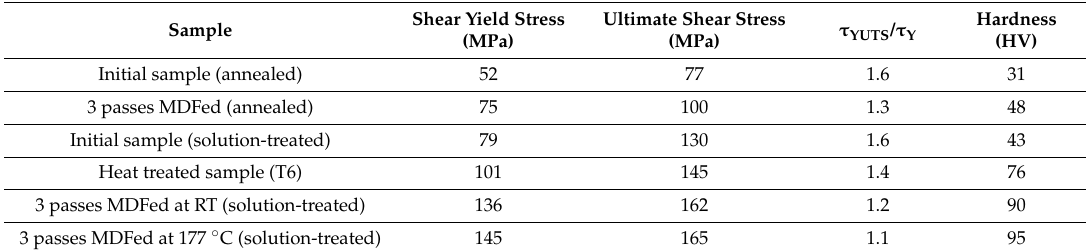
Table 1. Mechanical testing results for the annealed, solution-treated, and T6 samples of AA-6063.